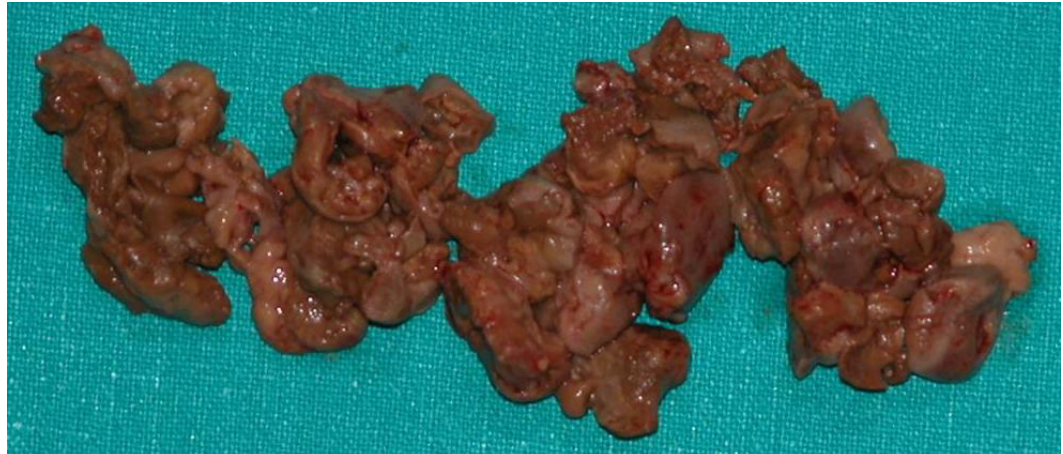
FIGURE 2. Amorphous and brown colored material: mycetoma by C.